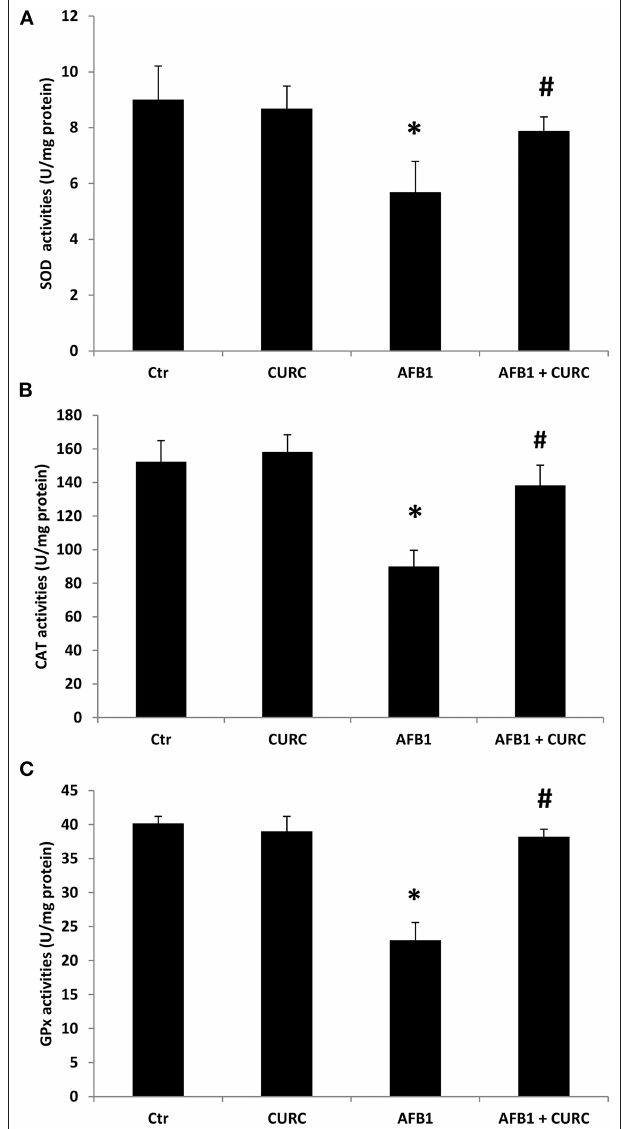
FIGURE 1 | Effects of Curcumin (CURC) and Aflatoxin B1 (AFB1) on superoxide dismutase (SOD), catalase (CAT), and glutathione peroxidase (GPx) activities in broiler renal tissue at the end of treatment (T10). (A) Renal SOD activity, (B) renal CAT activity, (C) renal GPx activity. Ctr, control group; CURC, Curcumin group; AFB1, Aflatoxin B1 group; AFB1 + CURC, Aflatoxin B1 group plus Curcumin. Data are expressed as mean ± standard deviation (SD), n = 8 (* p < 0.05 vs. Ctr; # p < 0.05 vs.